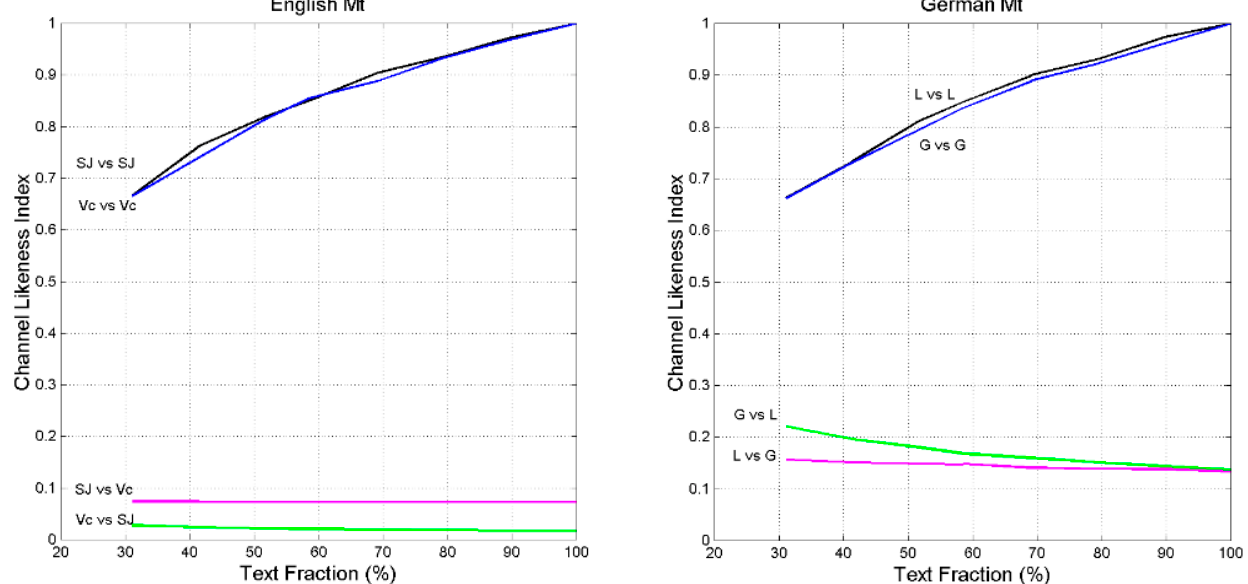
Figure 18. I L vs. text fraction in Matthew self- and cross-channels. Left panel : Modern English Figure 18. 𝐼 (cid:3013) vs. text fraction in Matthew self ‐ and cross ‐ channels. Left panel: Modern English (Vc) ‐ (Vc)-version studied in the present paper-versus the XVII century English of King James’ Bible (SJ). version studied in the present paper ‐ versus the XVII century English of King James’ Bible (SJ). In In the cross-channel Vc vs. SJ (green line) g 1 ( y ) refers to King James .; in the cross-channel SJ vs. Vc the cross ‐ channel Vc vs. SJ (green line) 𝑔 (cid:2869) (cid:4666)𝑦(cid:4667) refers to King James .; in the cross ‐ channel SJ vs. Vc (magenta line) g 1 ( y ) refers to modern English. Right panel : Modern German (G)-version studied in (magenta line) 𝑔 (cid:2869) (cid:4666)𝑦(cid:4667) refers to modern English. Right panel: Modern German (G) ‐ version studied the present paper- versus the XVI century German of Luther’s Bible (L). In the cross-channel G vs. L in the present paper ‐ versus the XVI century German of Luther’s Bible (L). In the cross ‐ channel G (green line) g 1 ( y ) refers to Luther ; in the cross-channel L vs. G (magenta line) g 1 ( y ) refers to modern vs. L (green line) 𝑔 (cid:2869) (cid:4666)𝑦(cid:4667) refers to Luther ; in the cross ‐ channel L vs. G (magenta line) 𝑔 (cid:2869) (cid:4666)𝑦(cid:4667) refers to German. All texts have been downloaded from the web sites reported in modern German. All texts have been downloaded from the web sites reported in [1].